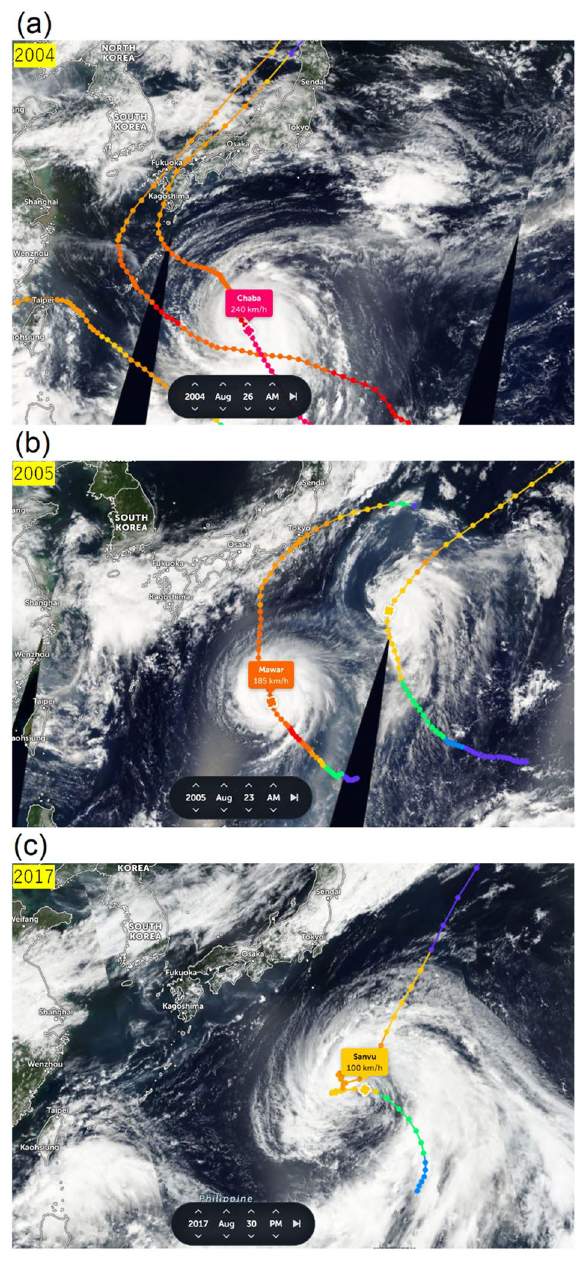
Figure 7. Satellite cloud images from zoom earth showing typhoons on ( a ) August 26, 2004 ( b ) August 23, 2005, and (c) August 30, 2017. Different colors represent different wind speeds, from blue (weak) to red (strong). Typhoon information and satellite image were observed from ZOOM EARTH (https:// zoom.